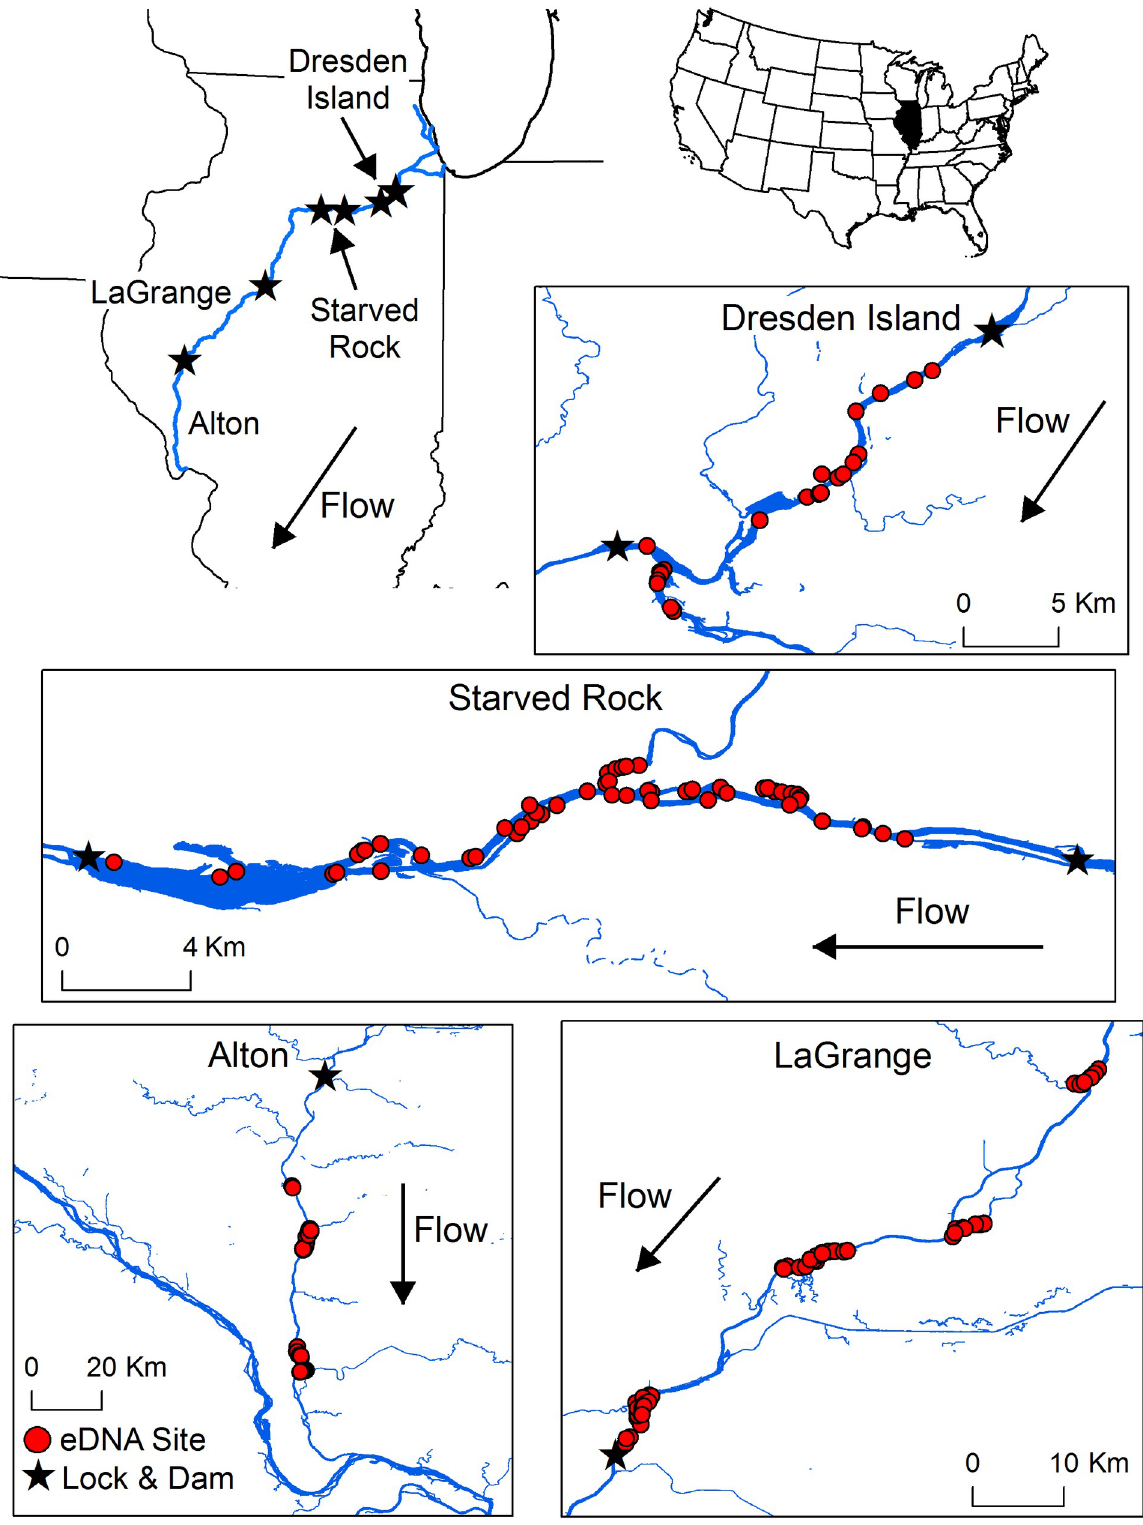
Fig 1. Locations (N = 192) across four reaches (Dresden Island, Starved Rock, LaGrange, Alton) of the Illinois River, USA where surface water samples were collected (eDNA Site) to assess Silver Carp eDNA concentrations. Simultaneous mobile hydroacoustic surveys were also conducted across all eDNA collection sites to quantify Silver Carp densities (survey paths not